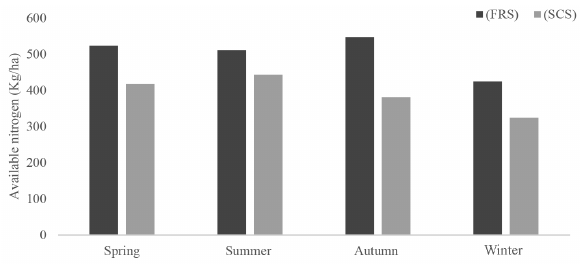
Figure 4. Seasonal variation in soil organic carbon at FRS and SCS